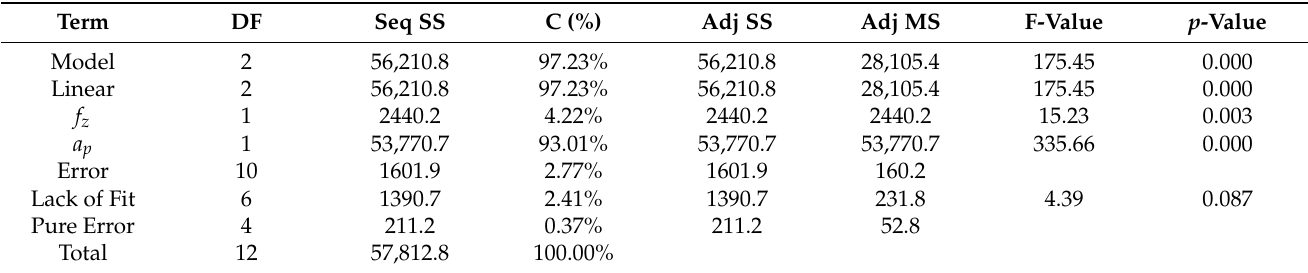
Figure 9. Axial cutting force component F a model. Table 6. Analysis of variance for the F a cutting force component model.